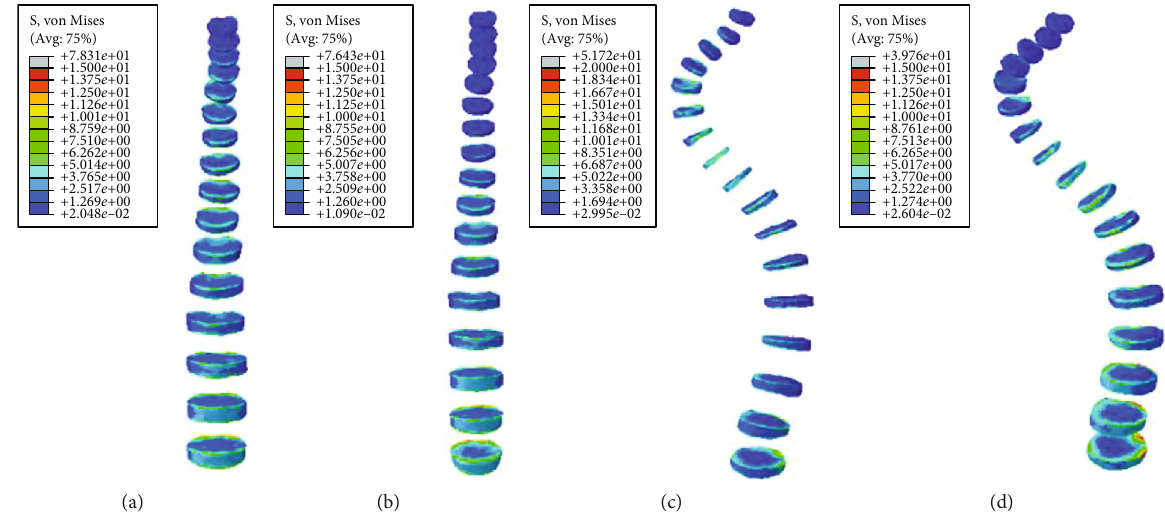
Figure 8: von Mises stress distribution of disc in four spinal models with anterior tilt: (a) normal spine without rib cage (NS1); (b) normal spine with normal rib cage (NS2); (c) scoliotic spine without rib cage (SS1); (d) scoliotic spine with deformed rib cage